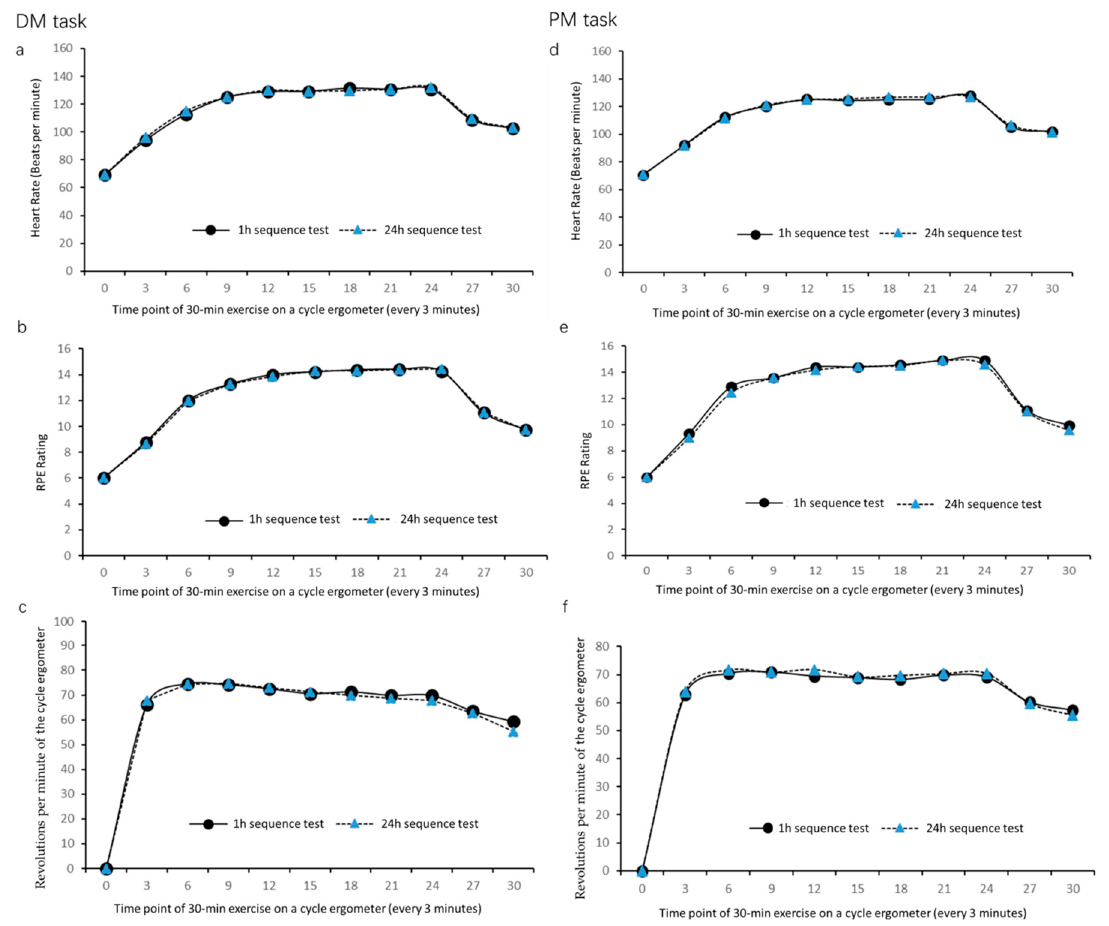
Figure 3. Physiological data obtained during the DM task and PM task. ( a – c ) DM task: heart rate (HR) ( a ); rating of perceived exertion (RPE) ( b ); and revolutions per minute (RPM) ( c ). ( d – f ) PM task: HR ( d ); RPE ( e ); and RPM ( f ). For both tasks, data were collected every 3 min during the exercise bout.